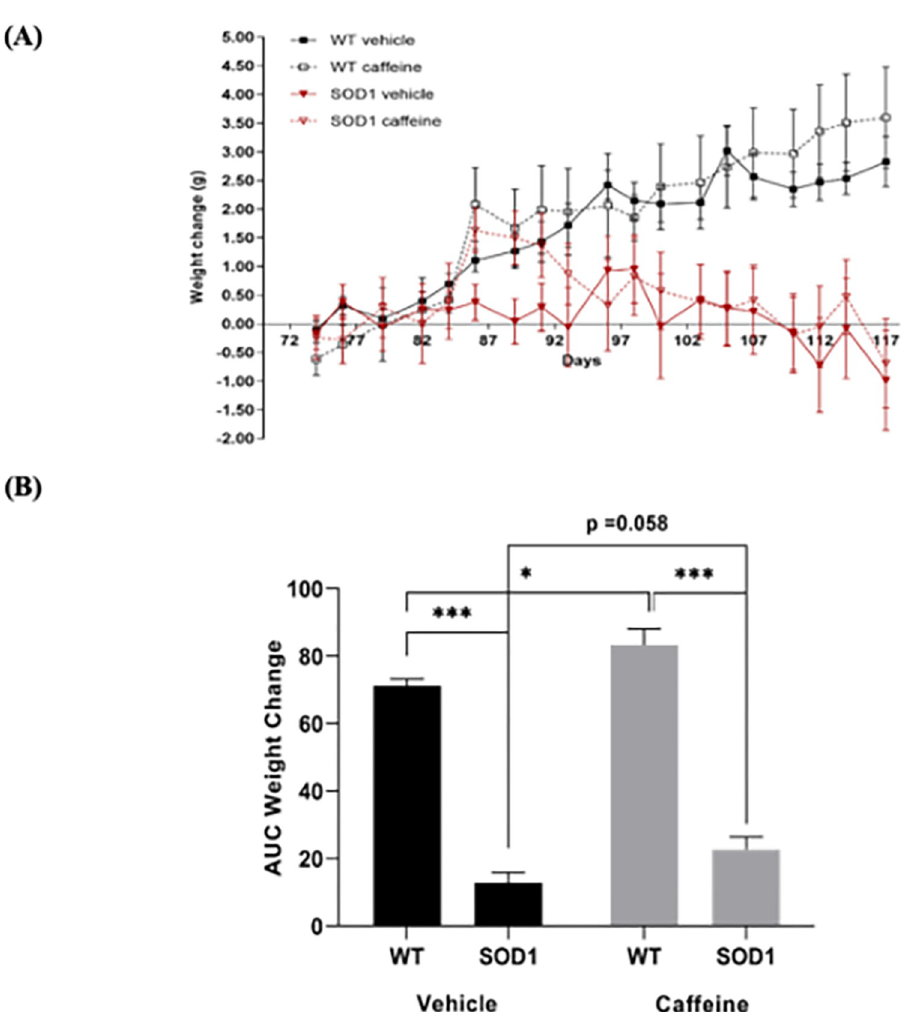
Fig 4. Effect of chronic caffeine treatment on animal weight gain over time. (A) The Y-axis represents the weight change caffeine treated/non-treated WT or SOD1 G93A animals in relation to the first day of treatment. The X-axis represents the days of treatment. (B) Area under the curve (AUC) of weight change for caffeine treated/non-treated WT or SOD1 G93A animals. Data are expressed as mean ± SEM (n = 6–10 animals); � p < 0.05; ��� p � 0.001, two-way ANOVA with Holm-Sidak correction for multiple